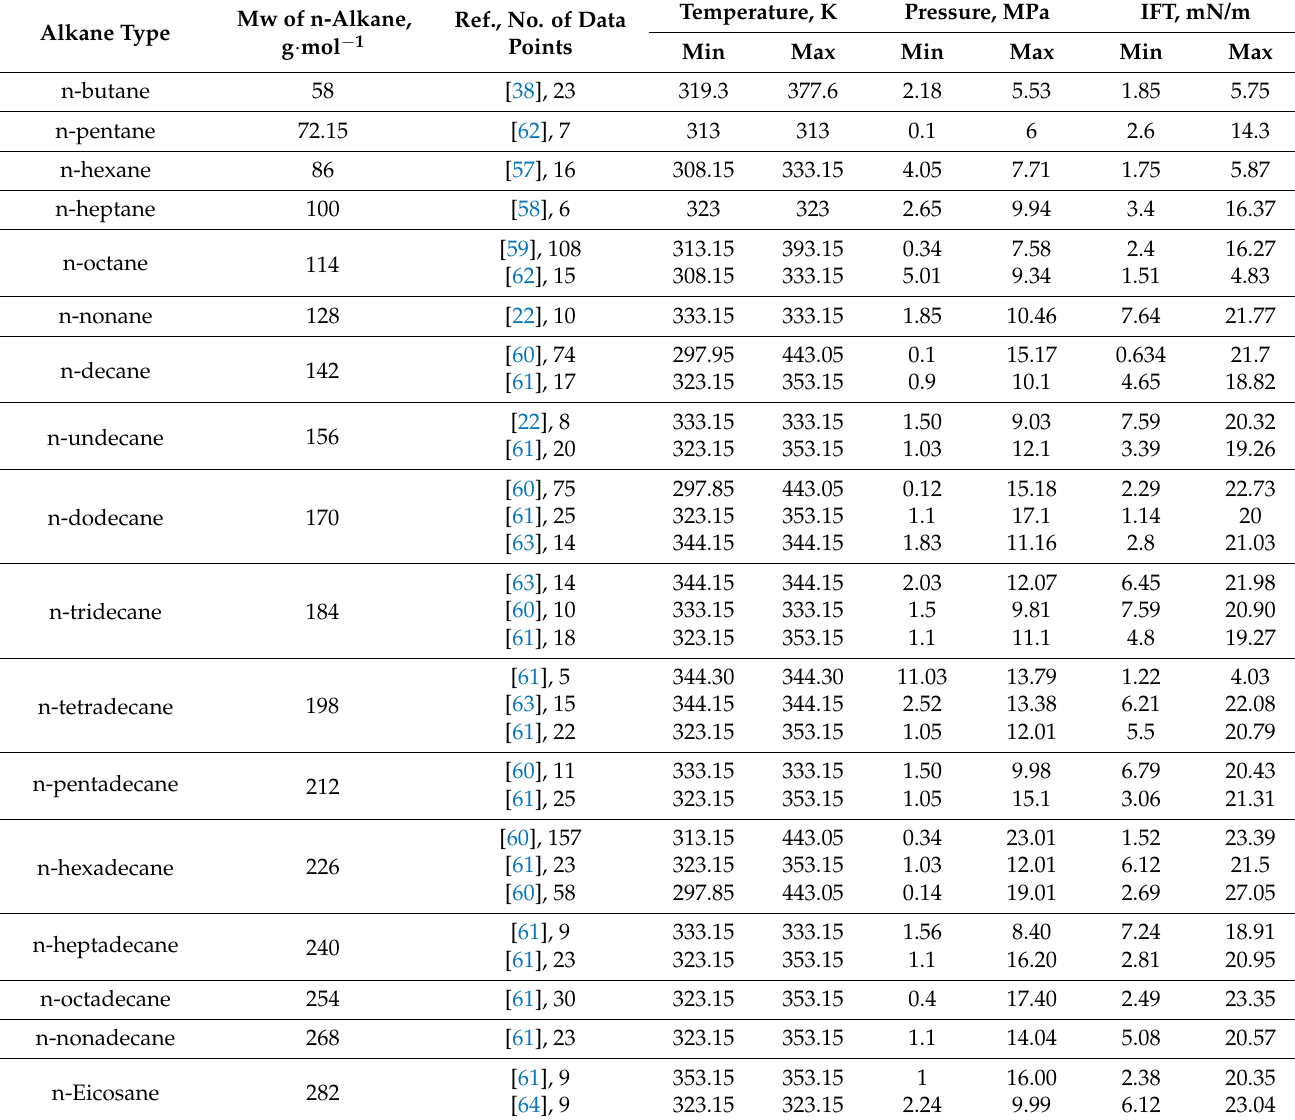
Table 1. Experimental IFT data used in this